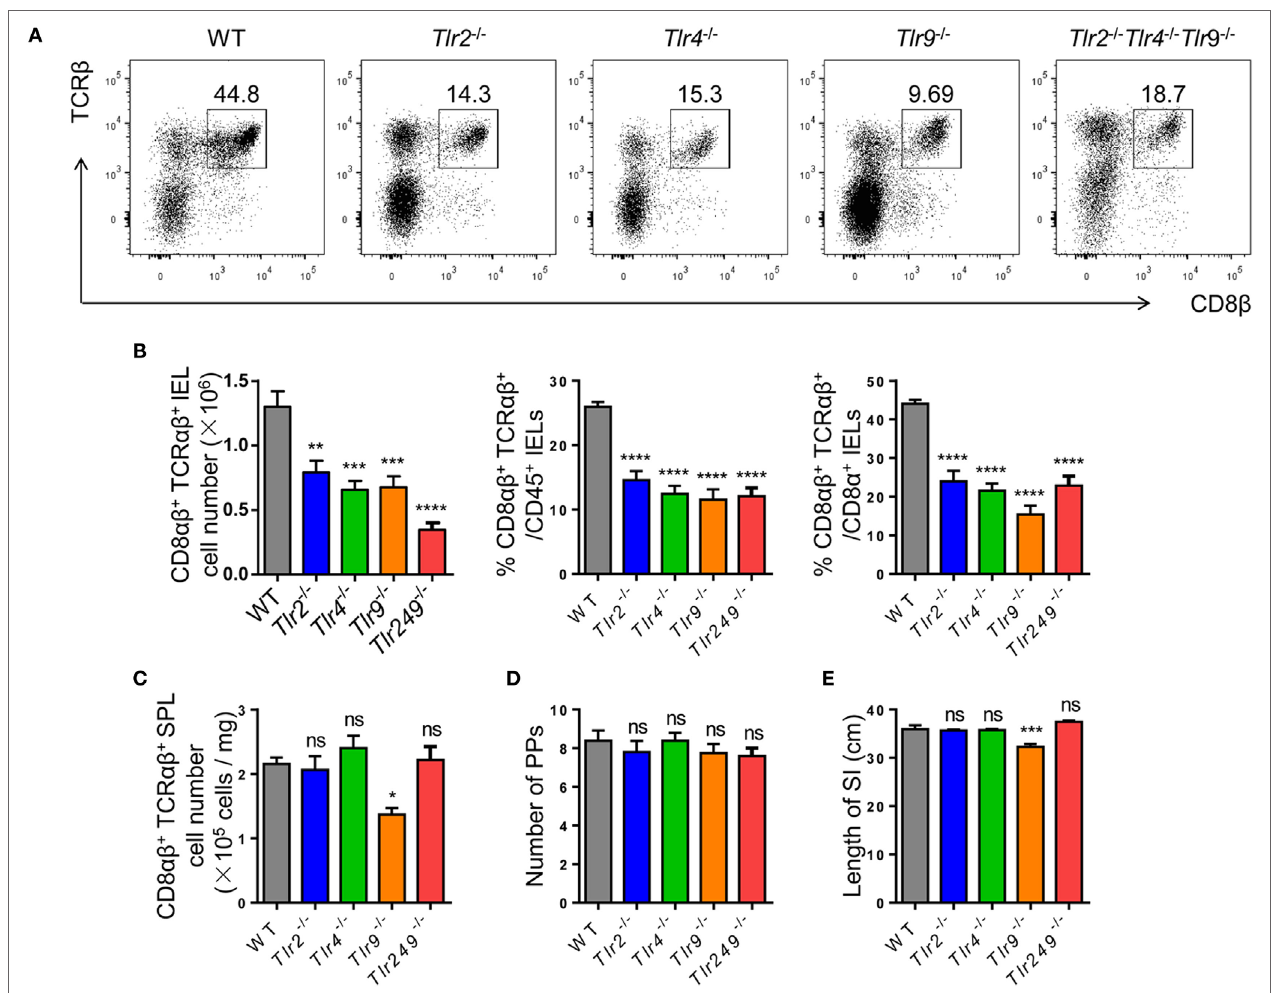
FigUre 3 | Commensal bacteria regulate the number of CD8 αβ + IELs via TLR (TLRs). (a,B) CD8 αβ + IELs from WT, TLR2 − / − , TLR4 − / − , TLR9 − / − , and TLR2 − / − TLR4 − / − TLR9 − / − mice were gated by the strategy shown in Figure 1a (a) . Absolute number and percentage of CD8 αβ + IELs from indicated mice were calculated (B) . (c–e) The absolute number of CD8 αβ + splenocytes (c) , number of PP’s scattered along the small intestine (D) , and length of the entire small intestine (e) in indicated mice were counted and compared, n = 4–5 mice per group. All mice used were on a C57BL/6 background. Data are representative of three independent experiments. One-way ANOVA followed by Dunnett’s test. Error bars represent the mean ± SEM. * P < 0.05, ** P < 0.01, *** P < 0.001, **** P < 0.0001. Abbreviations: ns, not significantly different; IEL, intraepithelial lymphocyte; SPL, splenocyte; PPs, Peyer’s